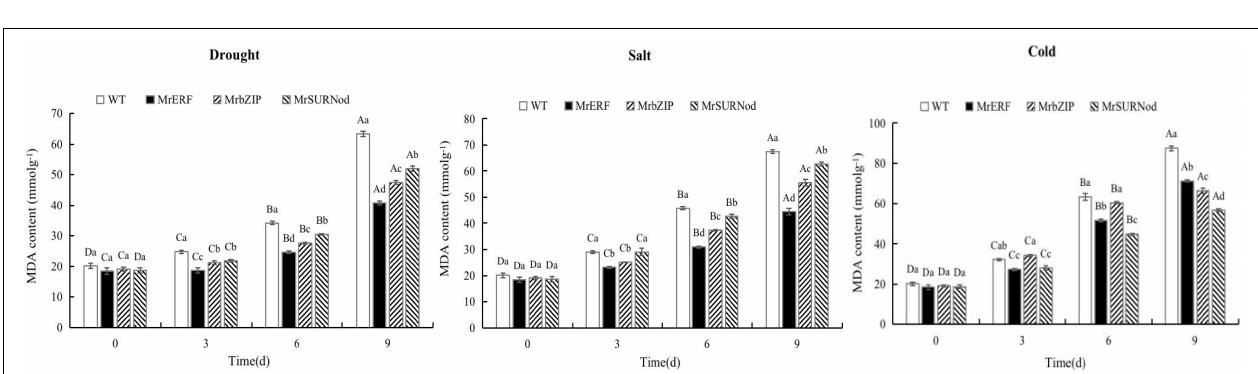
FIGURE 10 | Effects of different stresses on antioxidant enzyme activity of tobacco. Different capital letters indicate significant differences under different treatments, and different lowercase letters indicate significant differences among different transgenic lines in the same treatment ( P < 0.05).